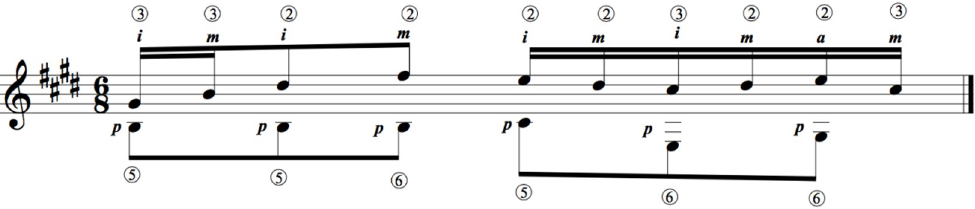
Figure 6. Viable Solution.